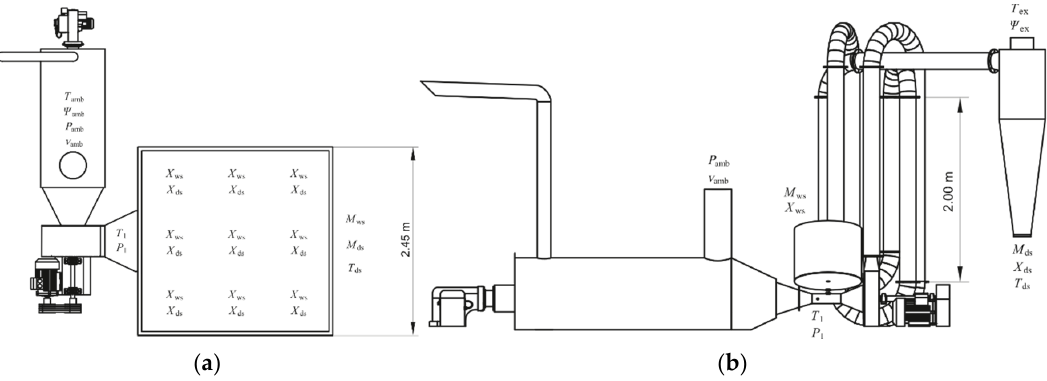
Figure 3. Measurements made at the dryers: ( a ) top-view of the fixed-bed dryer and ( b ) side-view of the pneumatic dryer ( T , temperature; Ψ , relative humidity; P, pressure; v, air velocity; ṁ , mass flow the pneumatic dryer ( T , temperature; Ψ , relative humidity; P , pressure; v , air velocity; ˙m , mass flow rate; X , moisture content). rate; X , moisture